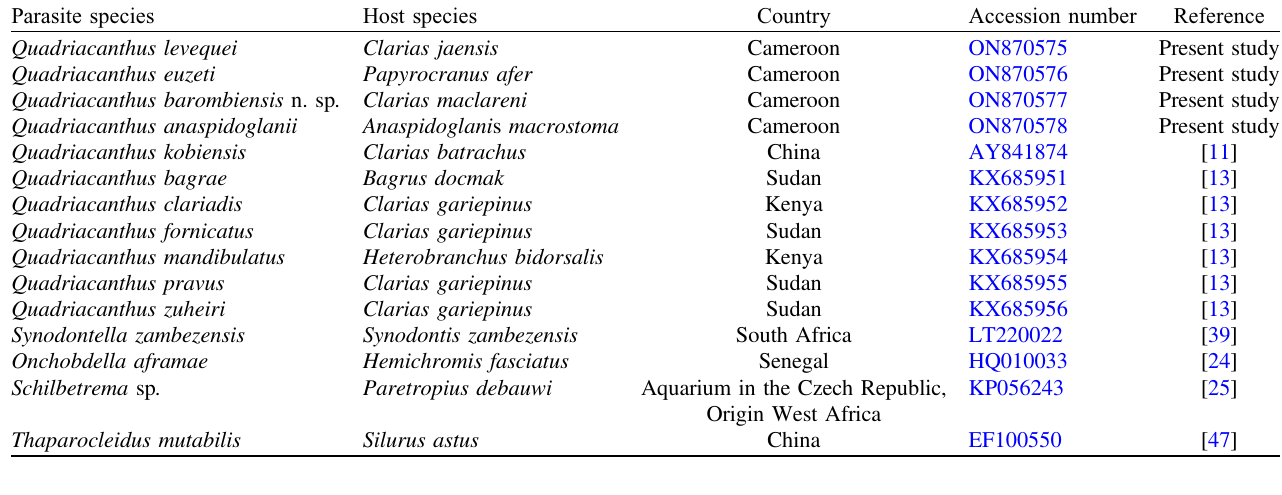
Table 2. List of the monogenean species used in this study, including their host, geographic location, accession numbers in GenBank, and the reference of their publication.